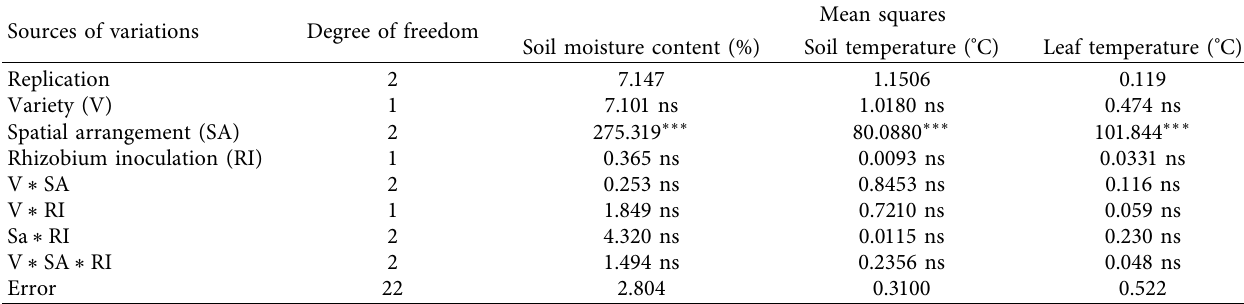
Table 3: Mean squares from analysis of variance (ANOVA) for soil moisture content (SMC %), soil temperature (ST o C), and leaf temperature (LT o C) common bean.